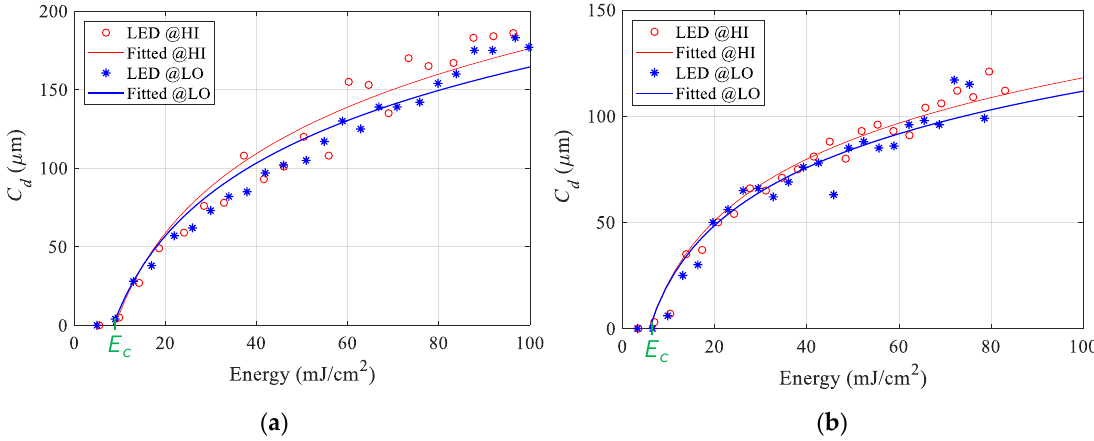
Figure 9. Working Curve from ( a ) continuous exposure pattern ( b ) discrete sequential pattern.